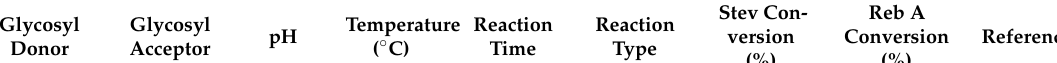
Table 3. Summary of the enzymatic modification of steviol glycosides using